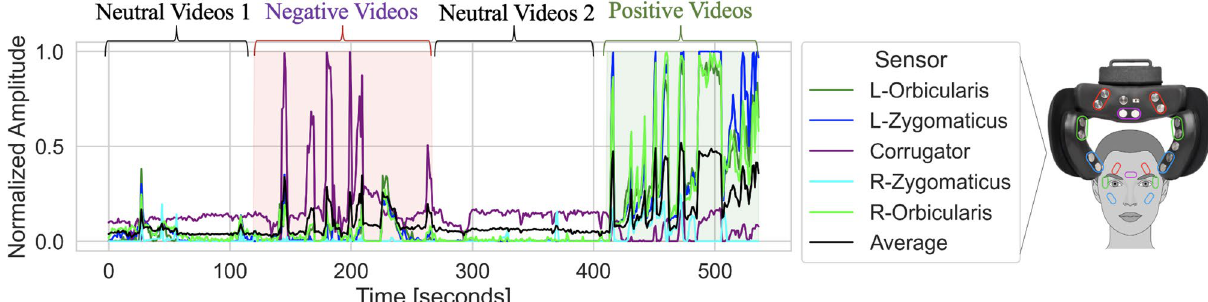
Figure 1. Example experimental session and sensor data collected for one subject. The lines represent the normalized sensor amplitudes for the five EMG sensors (left orbicularis, left zygomaticus, corrugator, right zygomaticus, and right orbicularis) and their average value. The session consists of 25 short videos.